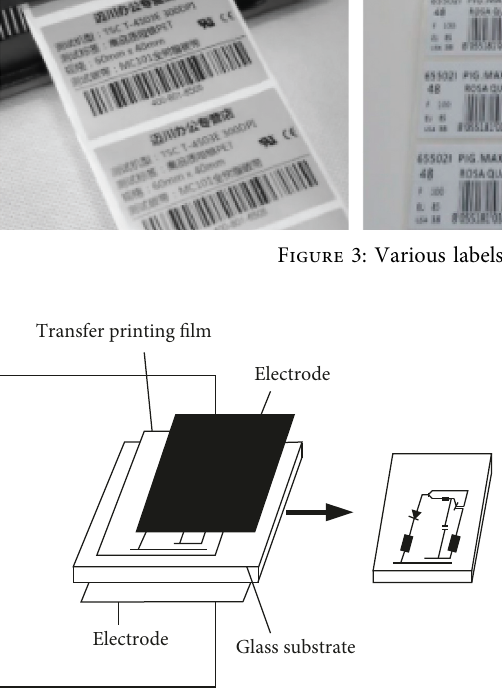
Figure 4: Schematic process diagram of electric field-induced thermal transfer of nanocrystalline patterns.